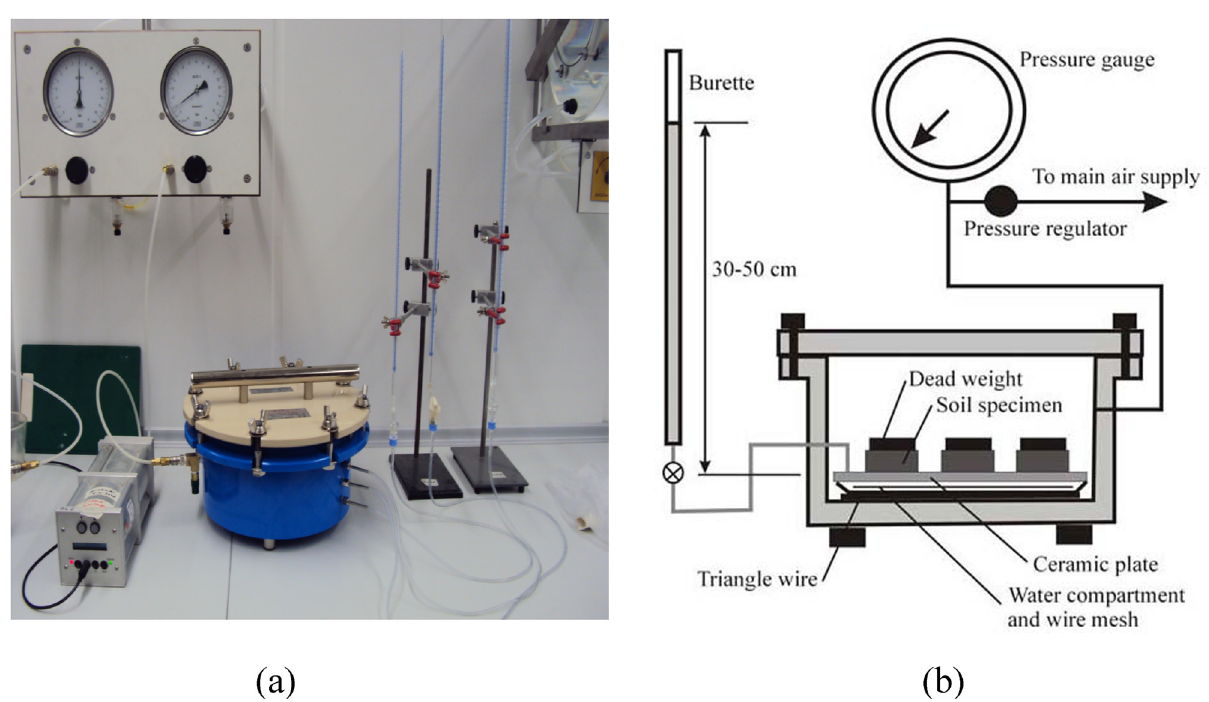
Figure 1: Pressure plate apparatus with axis - translation technique ( ATT ) : ( a ) device set up; ( b ) schematic